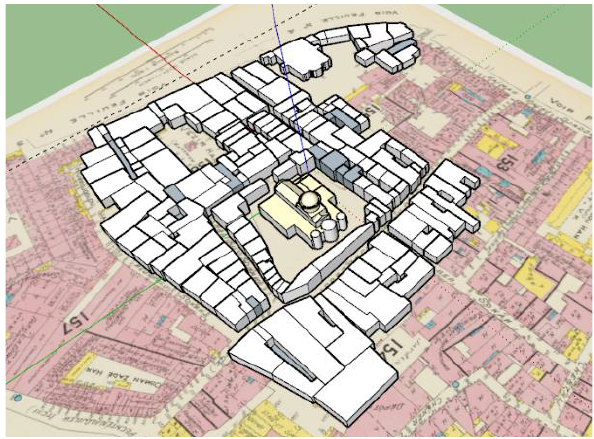
Figure 1. Virtual reconstruction process St. George Church